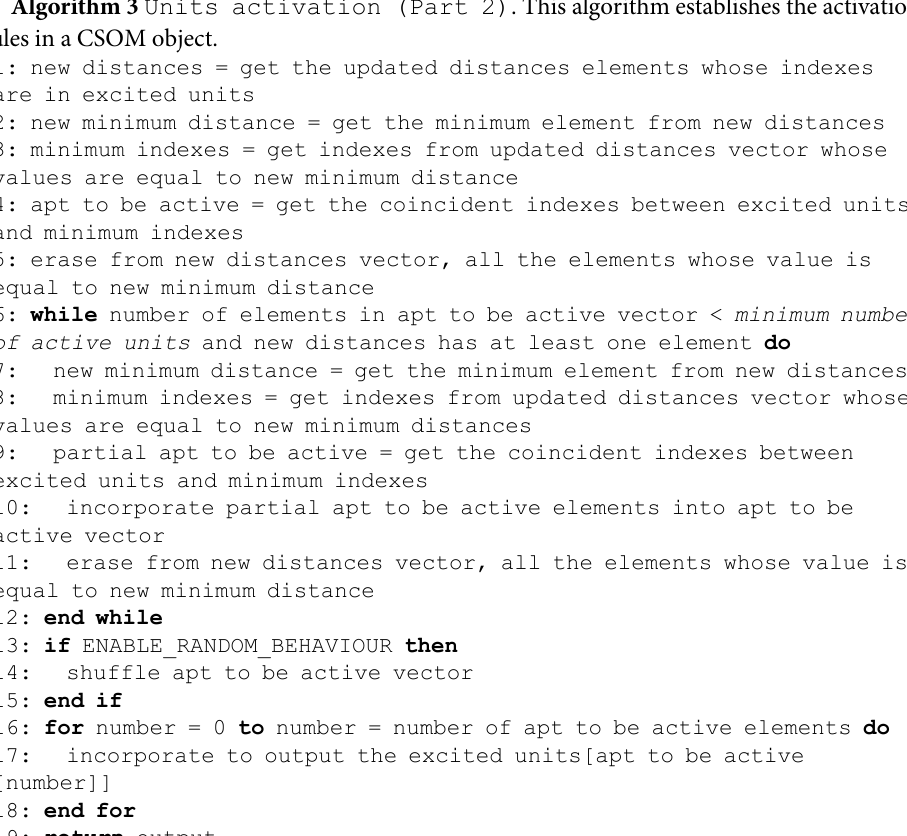
Algorithm 3 Units activation (Part 2) . This algorithm establishes the activation rules in a CSOM